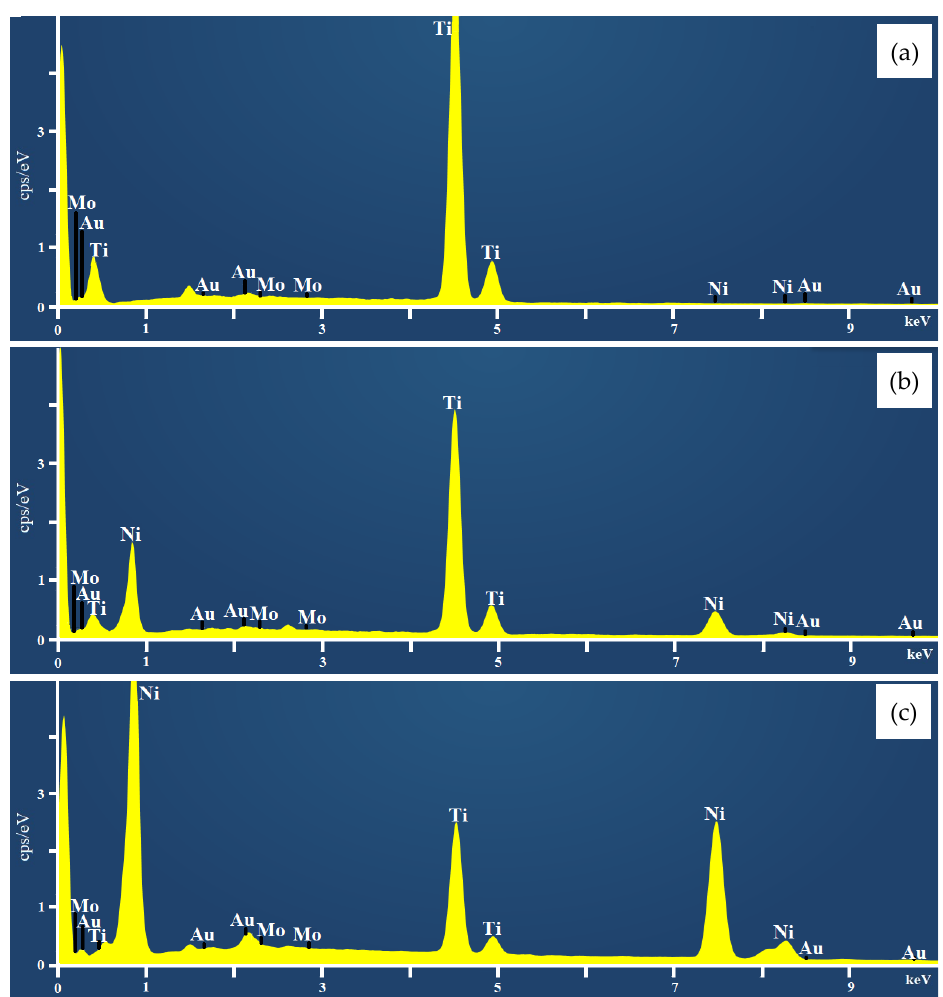
Figure 3. EDX spectra of Au(NiMo)/Ti-1 ( a ), Au(NiMo)/Ti-2 ( b ), and Au(NiMo)/Ti-3 ( c ) catalysts.